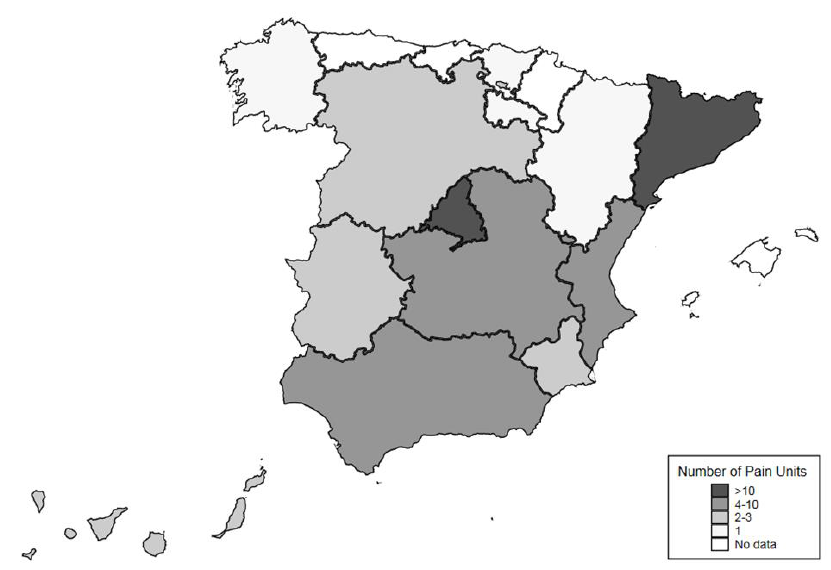
Figure 2. Number of surveyed pain units per autonomous community (region).